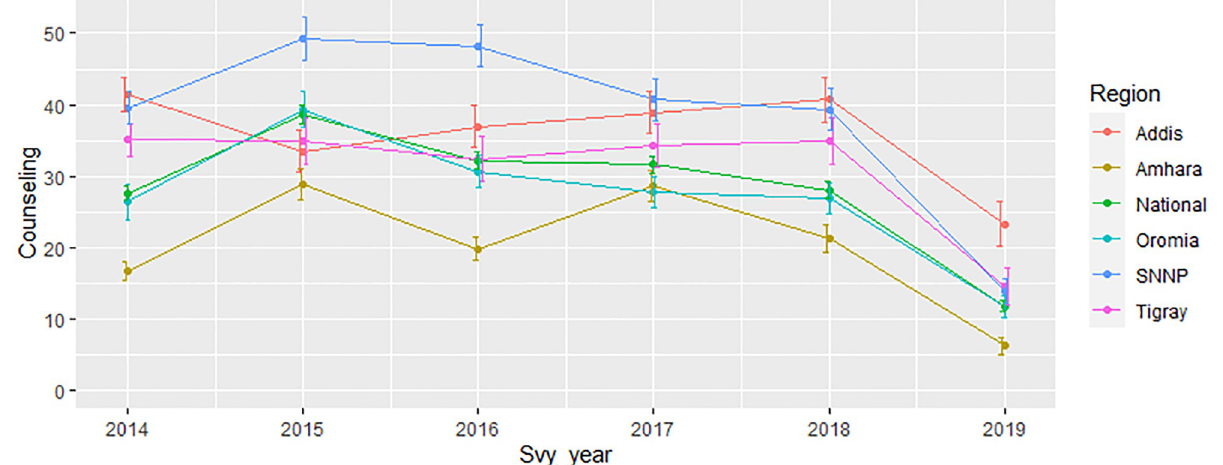
Fig 2. Percentage of women receiving high quality family planning counseling service over survey years by region.